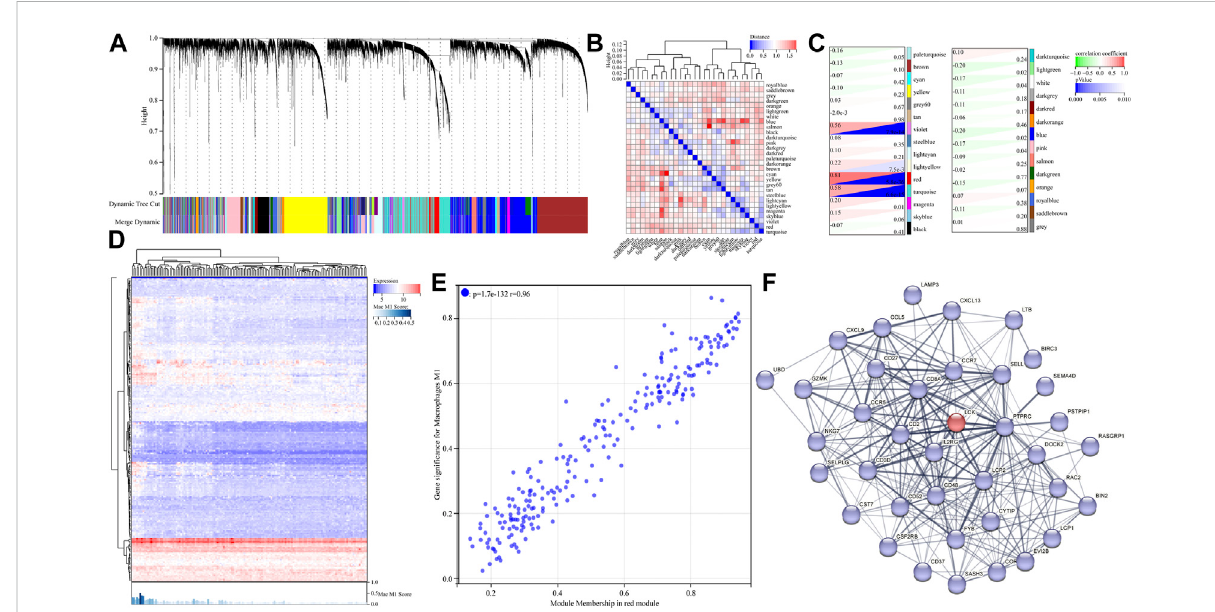
FIGURE 3 Identi fi cation of hub genes correlated with M1-like macrophage in fi ltration in the GSE21122 dataset. (A) Dendrogram of all differentially expressed genes clustered based on a dissimilarity measure. Dynamic tree cutting was applied to identify modules by dividing the dendrogram at signi fi cant branch points. (B) Heatmap of the adjacencies of modules along with the module trait relationship. (C) Correlation between the expression of the gene module and clinical characteristic (M1-like macrophage in fi ltration). (D) Heatmap of the expression level of genes in the red module obtained from WGCNA analysis. (E) Gene signi fi cance – module membership (GS-MM) scatter diagram of genes in THE red module. (F) Protein – protein interaction analysis of all candidate hub genes in the red module, via the STRING